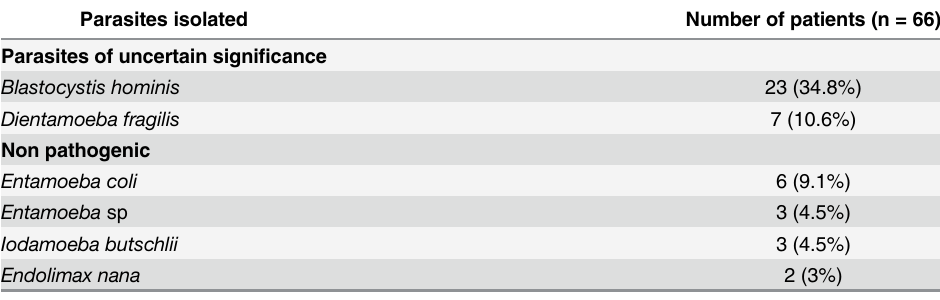
NOTE. Data are reported as number (%) of